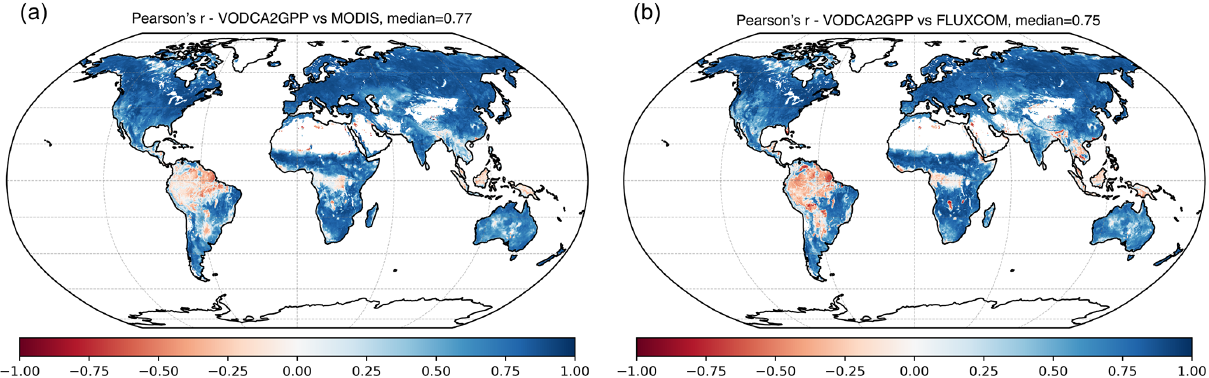
Figure 3. Pearson’s r between VODCA2GPP and MODIS GPP (a) and VODCA2GPP and FLUXCOM GPP (b) . The correlations are based on the common observation period between 2002 and 2016 with a 0.25 ◦ spatial and 8d temporal